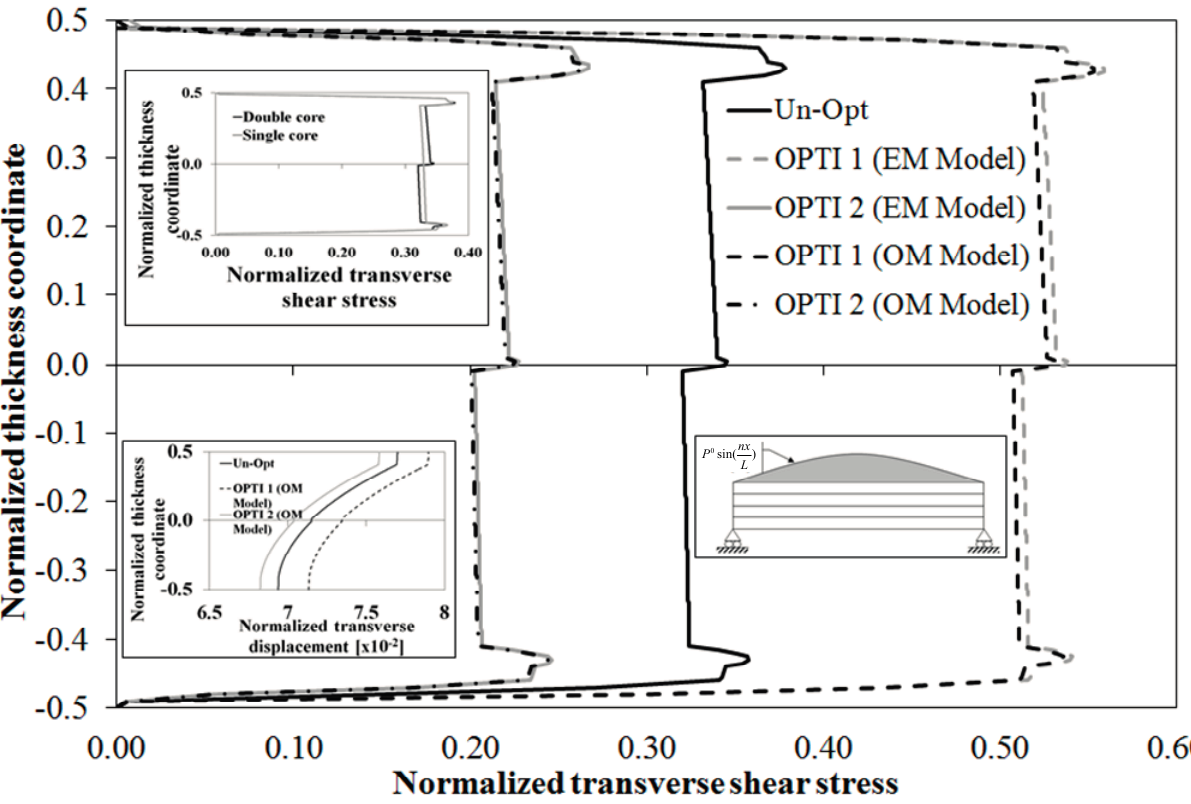
Figure 8. Normalized transverse shear stress by the OM Model and by the present EM Model for a simply-supported double core sandwich beam with spatially variable stiffness